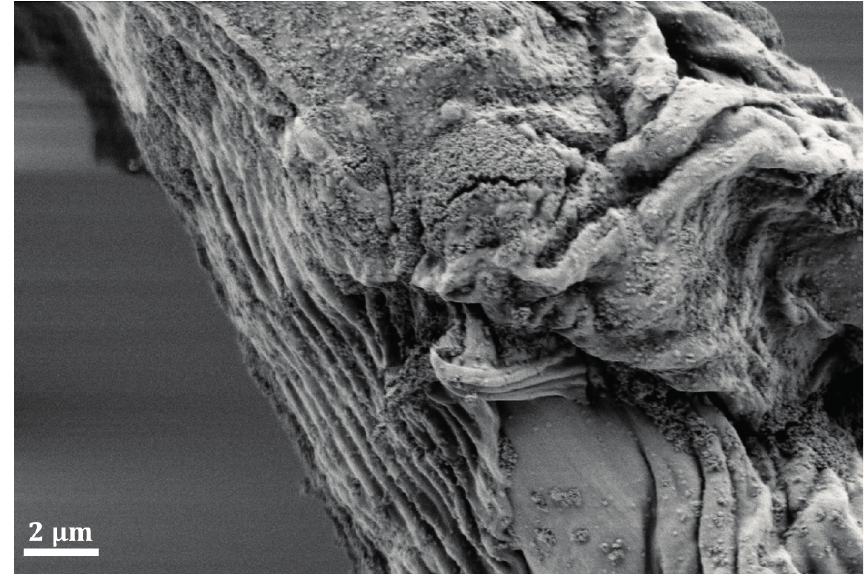
Figure 5. Hydrothermally obtained zirconia nanoparticles deposited on the surface of a chitinous template isolated from sponges. The inorganic particles form as huge conglomerates, as well as individual spherical